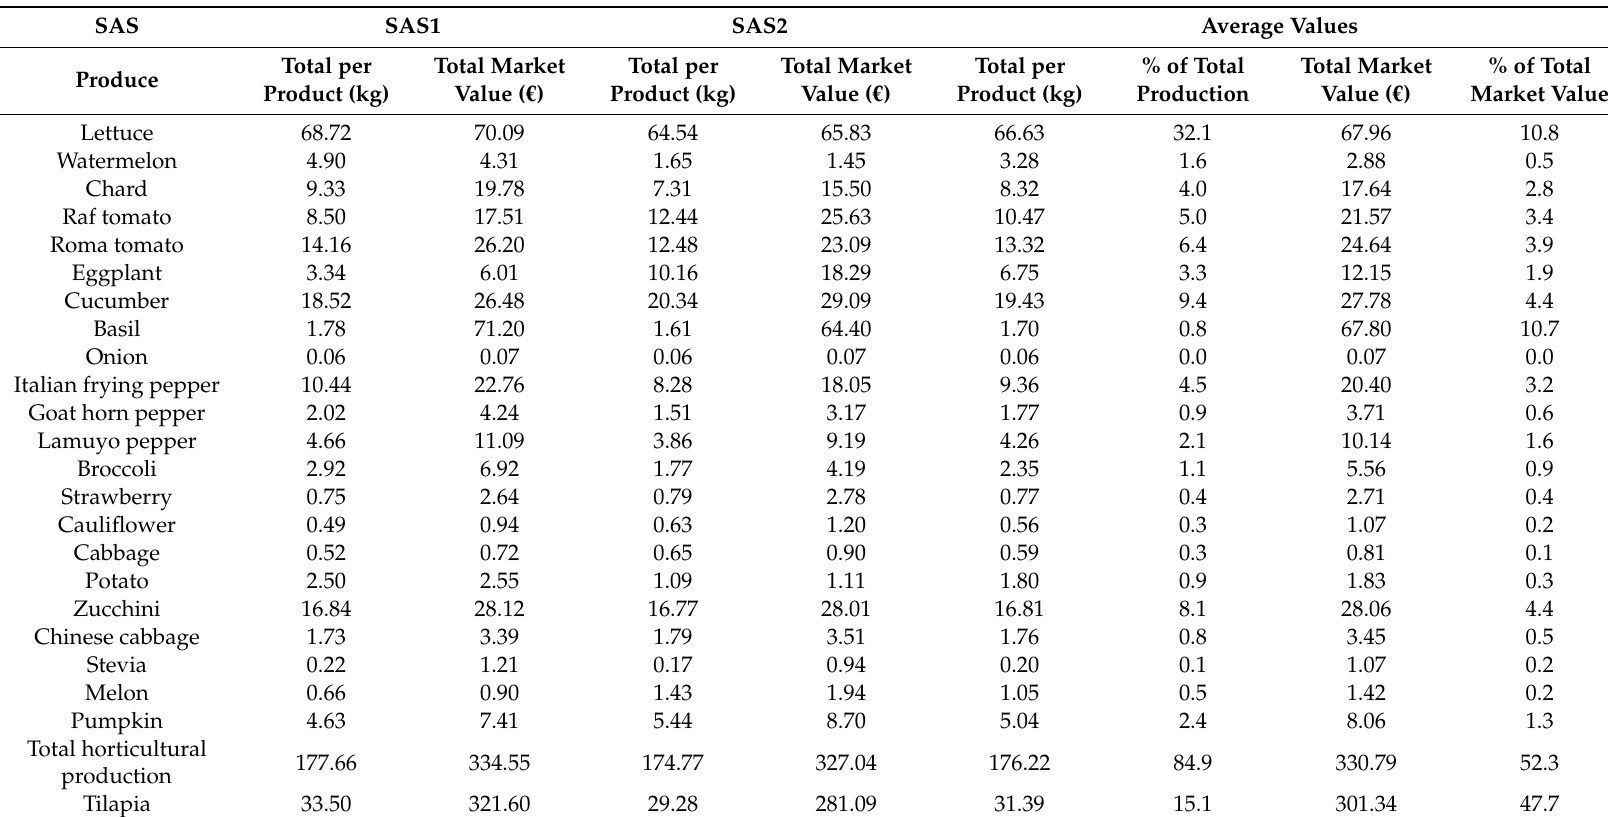
Table 1. Total horticultural and fish annual production (kg) and economic value of the production ( € ) per product in both aquaponic systems and average values (VAT